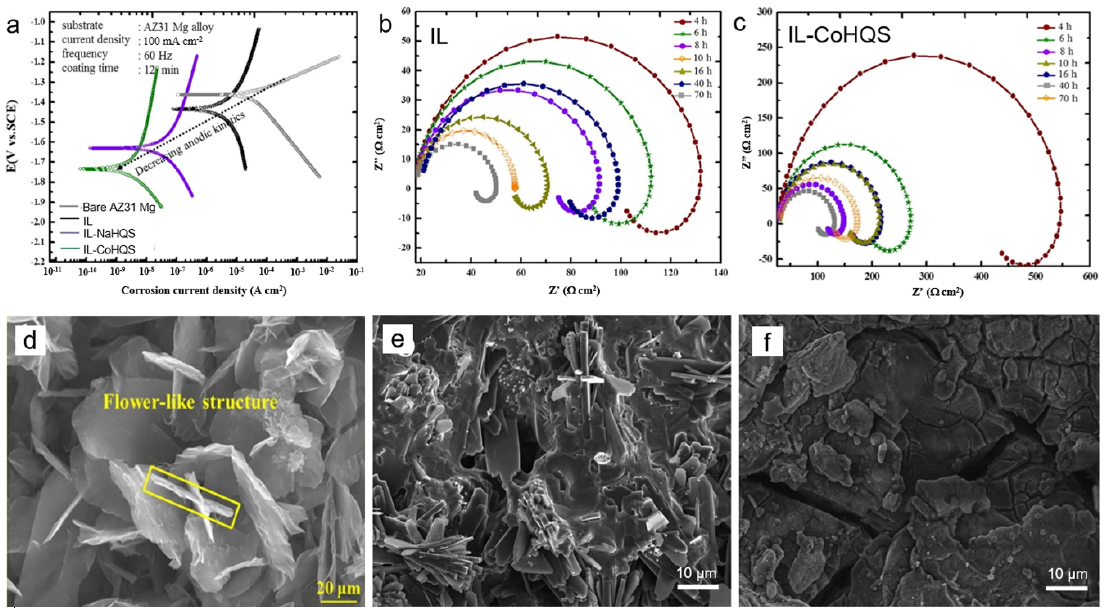
Figure 6. Electrochemical response showing ( a ) PDP curves of bare AZ31 Mg, IL, IL-NaHQS, IL-CoHQS after 1 h immersion and EIS curves of ( b ) IL and ( c ) IL-Co-HQS in 3.5 wt.% NaCl at different immersion times. Surface morphology of IL-CoHQS before ( d ) and after corrosion test ( e ) in 3.5 wt.% NaCl for 70 h showing structural stability as compared to that in IL ( f ) with identical immersion time. Redrawn with permission from [32]. Copyright © 2020 Elsevier.